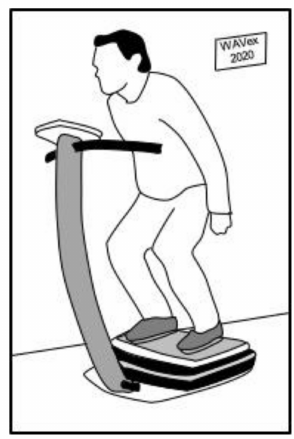
Figure 1. Conventional squat exercise on a WBV platform [54].